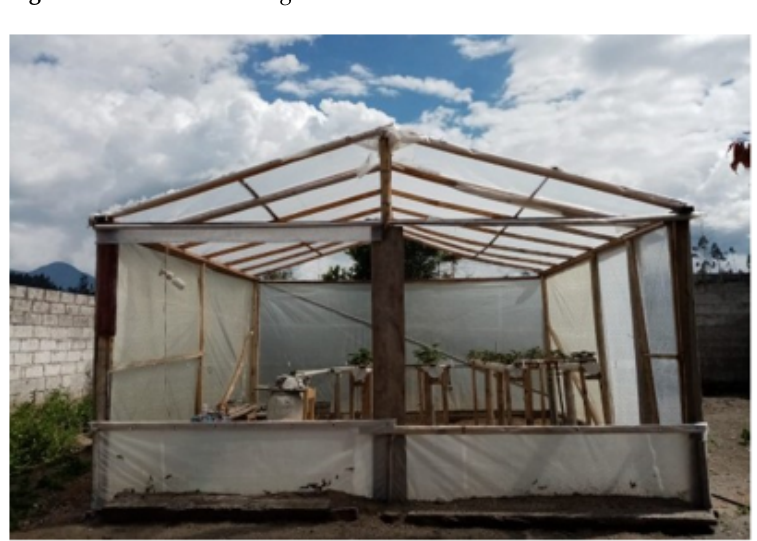
Figure 3. Front view of the greenhouse.